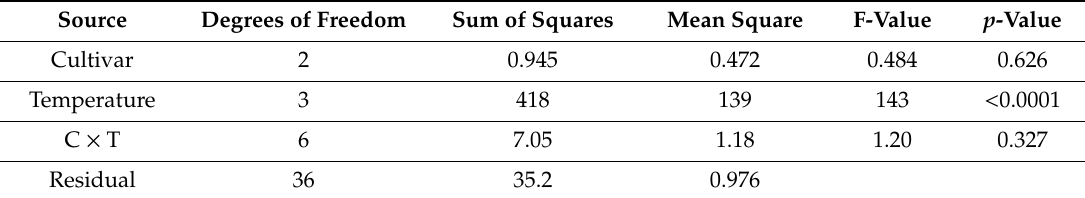
Table A3. Analysis of variance for photosynthetic rates measured at 200 µ mol mol − 1 C i for three soybean cultivars grown at 20 ◦ C.